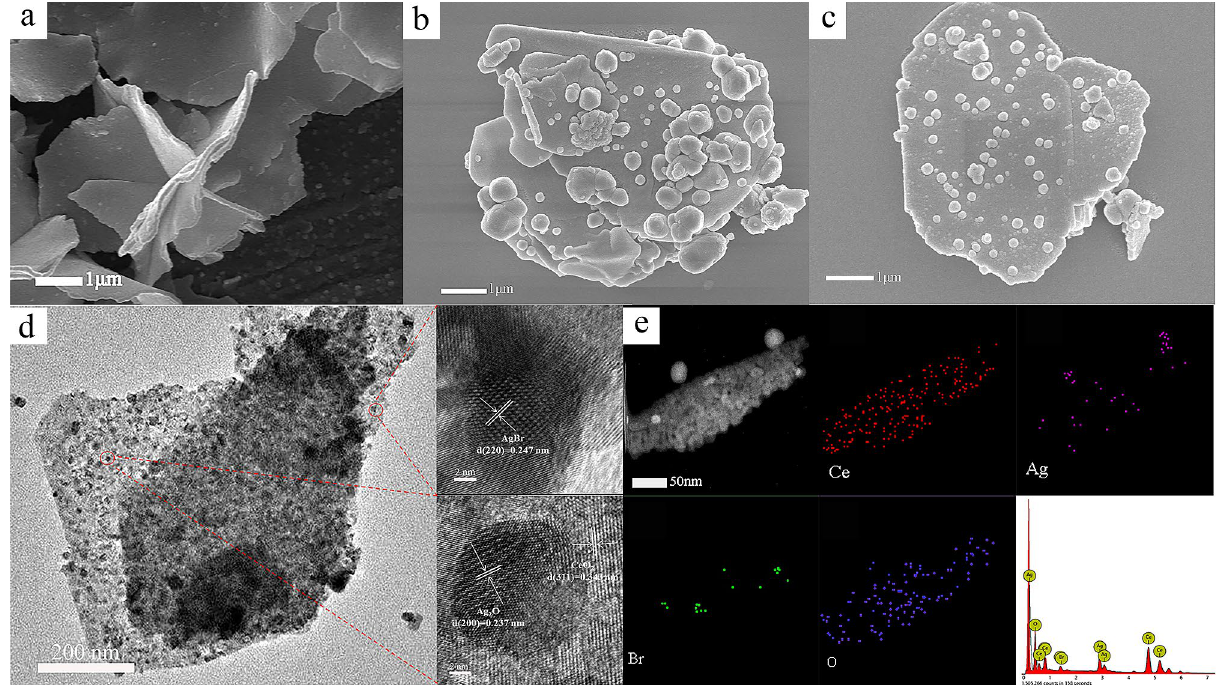
Figure 1. SEM images of ( a ) CeO 2 , ( b ) Ag 2 O–CeO 2 and ( c ) ACA-2; ( d ) TEM and HRTEM images of ACA-2; ( e ) EDX mapping of